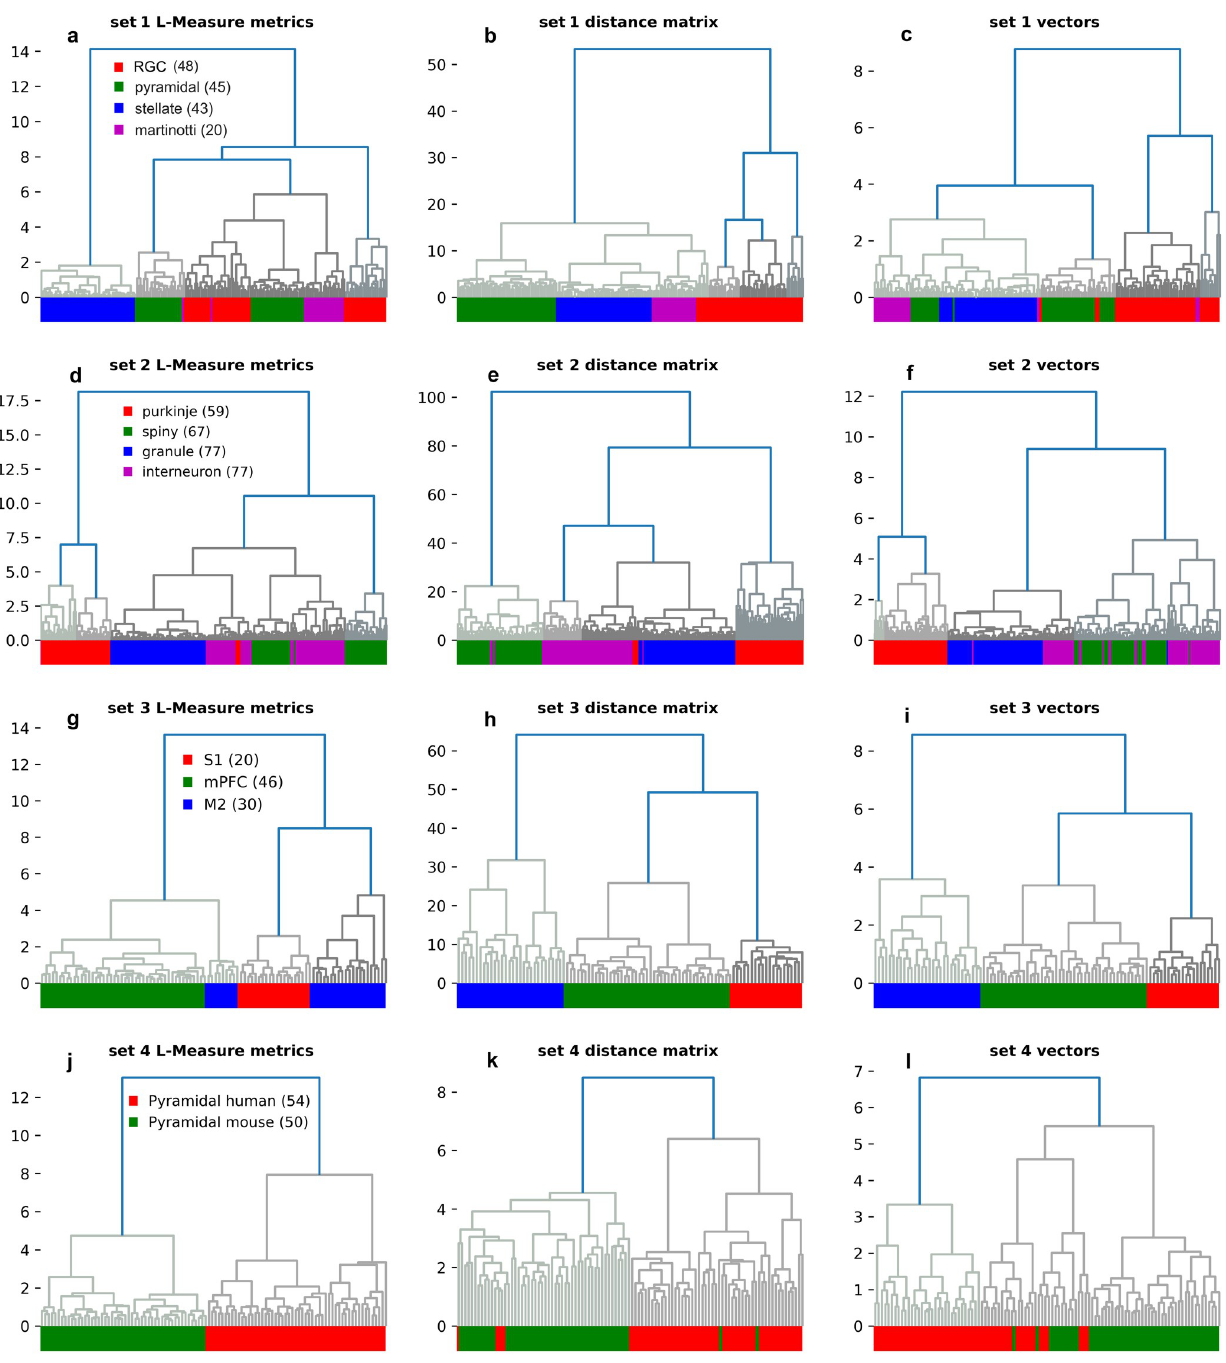
Fig 6. Hierarchical clustering trees comparing the L-Measure method, our combined Sholl descriptors, and our vector for all datasets. Representative dendrograms for morphological parameters extracted from ( a ) L-measure software, ( b ) Combined Sholl descriptors, and ( c ) our vector for dataset 1. Dendrograms for dataset 2 are presented in ( d,e,f ), dataset 3 ( g,h,i ), and dataset 4 ( j,k,l ). The “distance matrix” clustering is based on the distance matrix of the combined Sholl pseudo-metrics C.1 in S1 Text, while “vector clustering” is based on our unsupervized vectorization C.2 in S1 Text and Euclidean